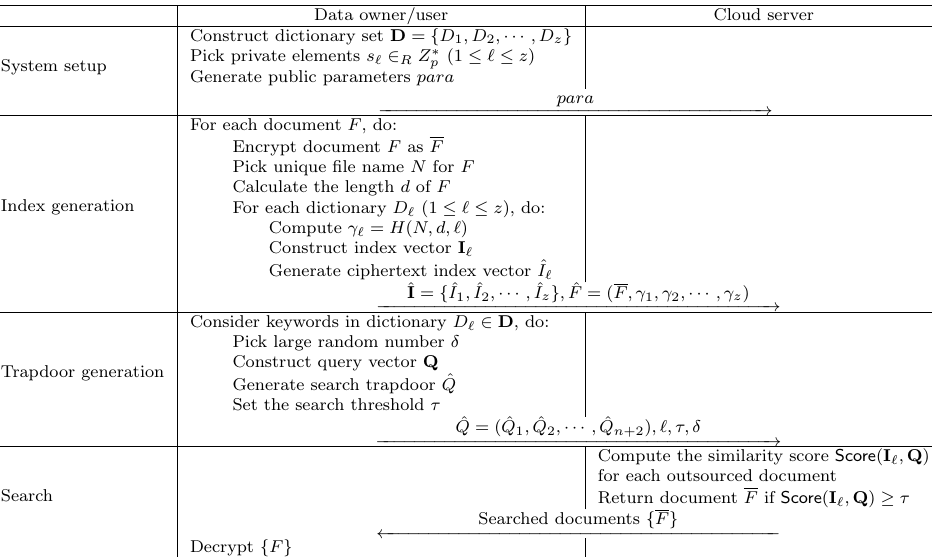
Fig. 5 The execution process of extended PRMS scheme Figure 4. The procedures of extended PRMS scheme.